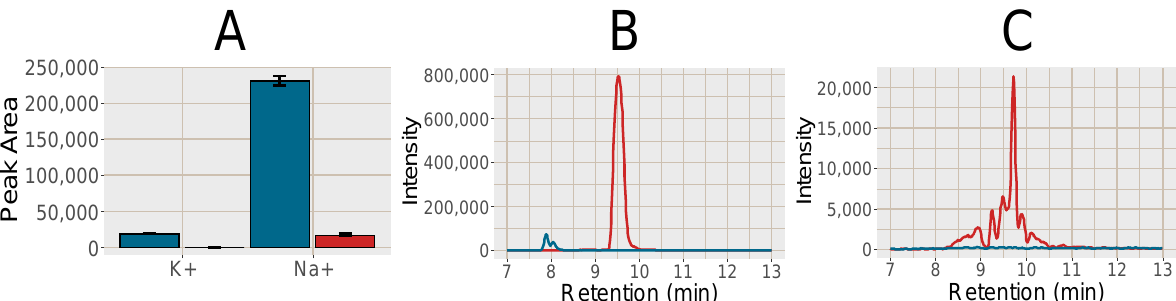
Figure 1. ( A ) Bar plot over the peak area of K + detected as K + (HCOOK), m / z 122.926 and Na + detected as Na + (HCOONa) 3 ), m / z 226.954 in the PPT (blue) and SPE MCX (red), error bars show the standard deviation (n = 10). ( B ) Chromatogram of K + (blue line) and Na + (red line) in the PPT. ( C ) Chromatogram of K + (blue line) and Na + (red line) in the SPE MCX.